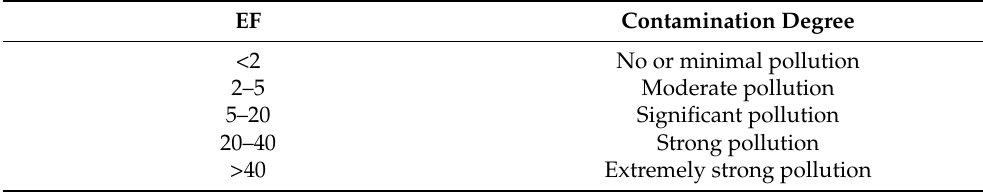
Table 1. Standard of contamination degree by enrichment